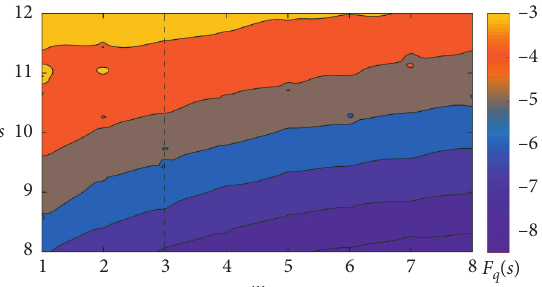
Figure 9: Different m-order F